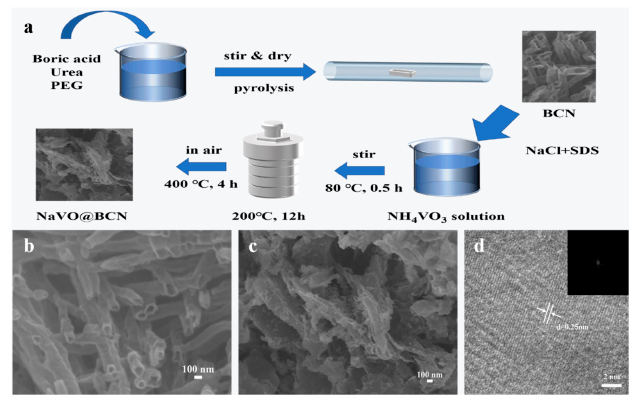
Figure 1. ( a ) Schematic diagram of the preparation of NaVO/BCN composites; ( b , c ) SEM images of the BCN nanotubes and NaVO@BCN-1; ( d ) HR-TEM image of the NaVO@BCN-1; inset: the SAED.